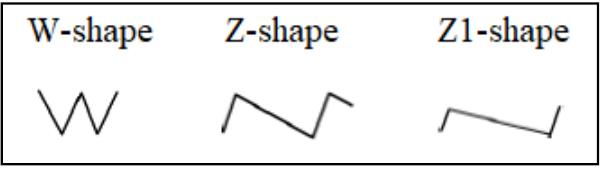
Figure 2. Water distribution system on a cooling pad surface.